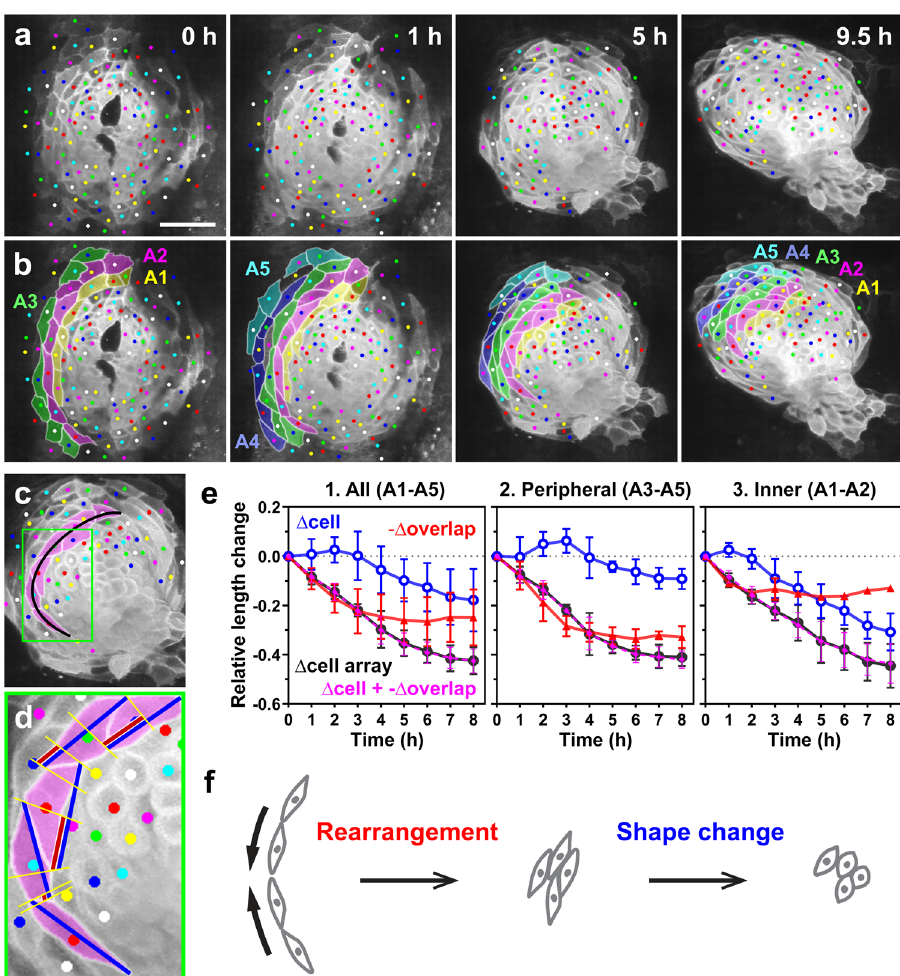
Fig. 4 Oriented cell rearrangement and cell shape change drive convergence of the cardiac disc at the early and late phases of heart tube formation, respectively. a , b For quantitative analysis, we considered cells circumferentially arrayed in a row (A1 – A5, each cell array is shown in a different color in b ) as a unit. a Selected images from a confocal time-lapse recording of a Tg(myl7:EGFP-CAAX) ncv536Tg embryo starting at 19 – 20 hpf. Dorsal view (anterior to the top). Scale bar = 50 µ m. b Colored, corresponding images to those in a . Cells in the left primordium (colored cells) were analyzed. Cell arrays are numbered from the inner to the peripheral order (A1 – A5). We measured the length of each cell array (black line in c ), the length of constituent cells (blue lines in d ) and the overlap length between neighboring cells (red lines in d ) every 1 h. c A cell array is indicated by magenta. d Enlargement of the region indicated by the box in c . e Relative length changes of cell arrays (black), cells (blue), and loss of the cell lengths caused by the cell overlap (red) in fi ve cell arrays ( e 1, A1 – A5 indicated in b ), in the peripheral cell arrays ( e 2, A3 – A5) and in the inner cell arrays ( e 3, A1 – A2). Magenta plots represent the sum of relative changes of cell length (blue) and the length loss by the cell overlap (red). n = 5 cell arrays, 4 – 8 cells per each cell array (1 embryo). Data are normalized relative to sum of cell lengths at the initial time point to eliminate the effects of each cell array size. Means ± s.d. are shown. Corresponding graphs indicating individual data points are shown in Supplementary Fig. 2. f Model for convergence of the cardiac disc based on our quantitative analysis. Circumferential convergence is initially driven by oriented cell rearrangement and subsequently by cell disc is almost bilaterally symmetric just after the left and right cell array convergence similarly to Fig. 4. Because the right pri- primordia merge at the midline. Our cell tracking showed that at mordium involutes ventrally and becomes hidden as the heart this stage left and right heart primordia equally compose each tube forms, we only could quantify cells in the anterior portion of half of the cardiac disc (Fig. 5a, 1 h). At this point, the anterior the primordium (colored regions in Fig. 5b and Supplementary and posterior borders of the left and right primordia were at 12 Movie 5) in a more limited time window as compared with that in and 6 o ’ clock, respectively. However, as the heart tube formed, the Fig. 4. The results showed that both the left and right heart pri- posterior border shifted to 7 o ’ clock (Fig. 5a, 5 h), and then to 9 mordia undergo circumferential convergence, but the con- o ’ clock (Fig. 5a, 9.5 h, n = 8/8 embryos), suggesting that the left vergence speed is asymmetric between the left and right halves primordium converged more rapidly than the right one. We (Fig. 5c and Supplementary Fig. 4a). The peripheral region of the quanti fi ed the circumferential length of the peripheries of the left left primordium converged more rapidly than the corresponding and right primordia (Supplementary Fig. 3b, c): the ratio of the region of the right primordium ( n = 3 embryos, Fig. 5c1), left peripheral length to the right one was initially 1:1 ± 0.04 (s.d.) whereas no signi fi cant left-right difference was found in the inner at 0 h, subsequently became 0.67:1 ± 0.04 (s.d.) at 4 h, and region (Fig. 5c2). 0.5:1 ± 0.04 (s.d.) at 8.5 h ( n = 3 embryos, Supplementary Fig. 3c, We next asked what cellular behavior is responsible for the uninjected embryos), supporting our notion. We quanti fi ed the asymmetric convergence of the left and right heart primordia.